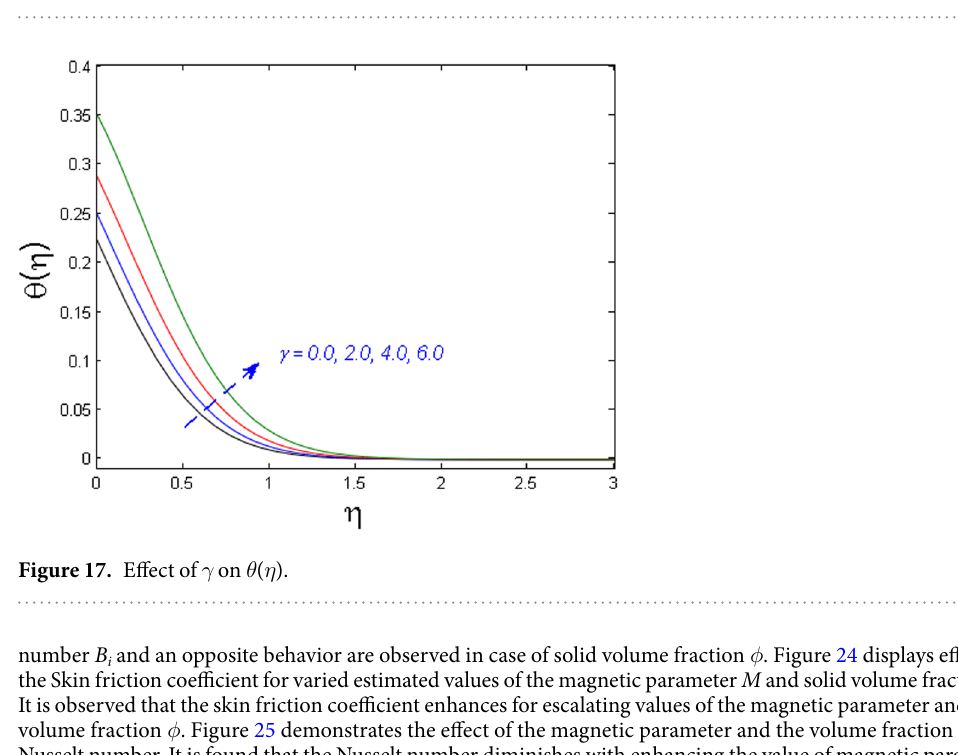
Figure 16. Effect of B i on θ ( η ).